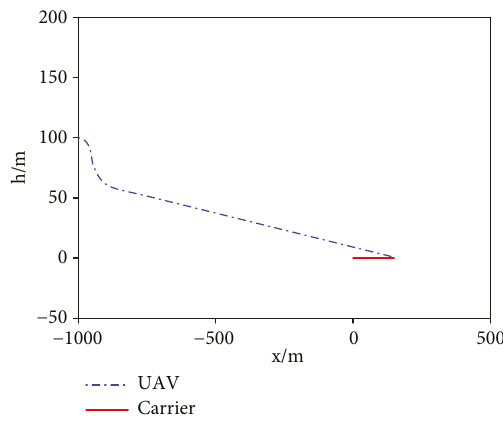
Figure 5: UAV landing trajectory in the vertical